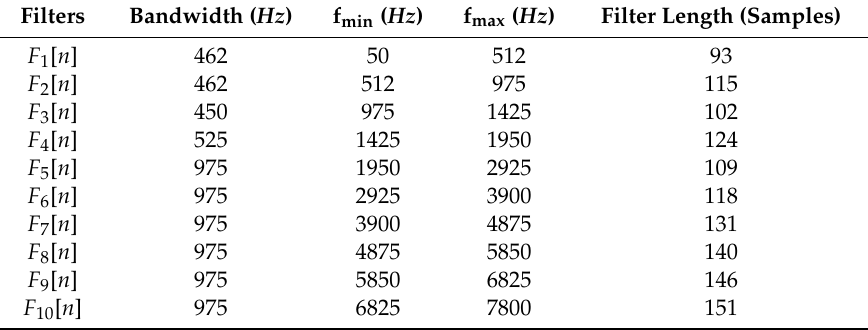
Table 2. The required information to design the analysis filter bank for sub-band processing in the proposed CNMA-SBAPA